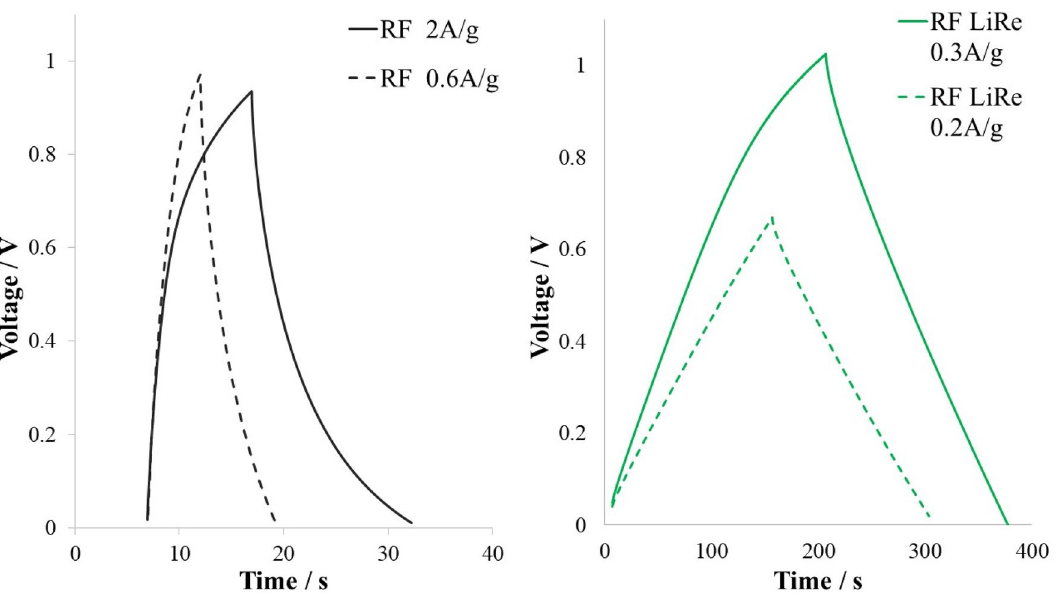
Fig. 6 Galvanostatic chargé/discharge curves obtained for gels prepared with sodium carbonate (RF) and lithium perrhenate (RF LiRe) cata-